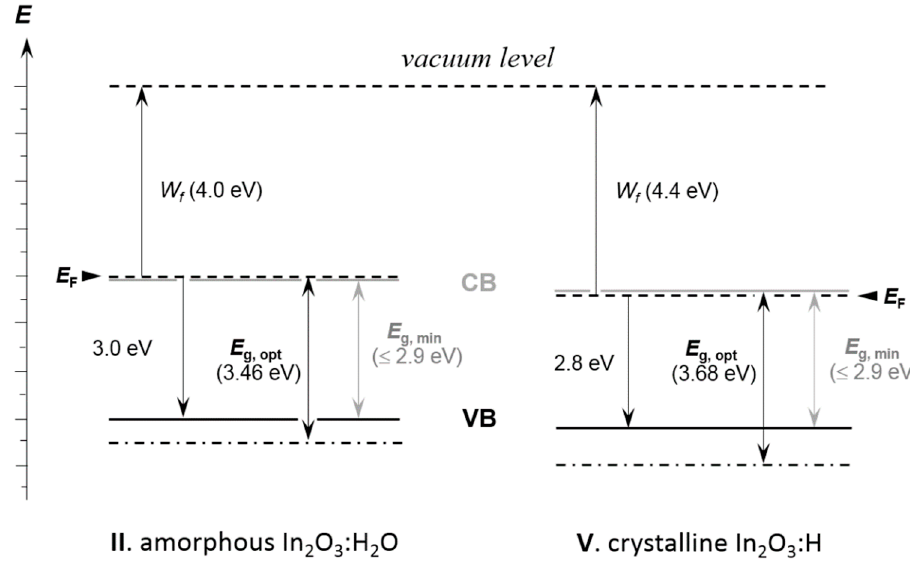
Figure 7. Energy diagram for indium oxide of the states II and V. The scheme is created on the basis of optical (UV-Vis) and UPS data.